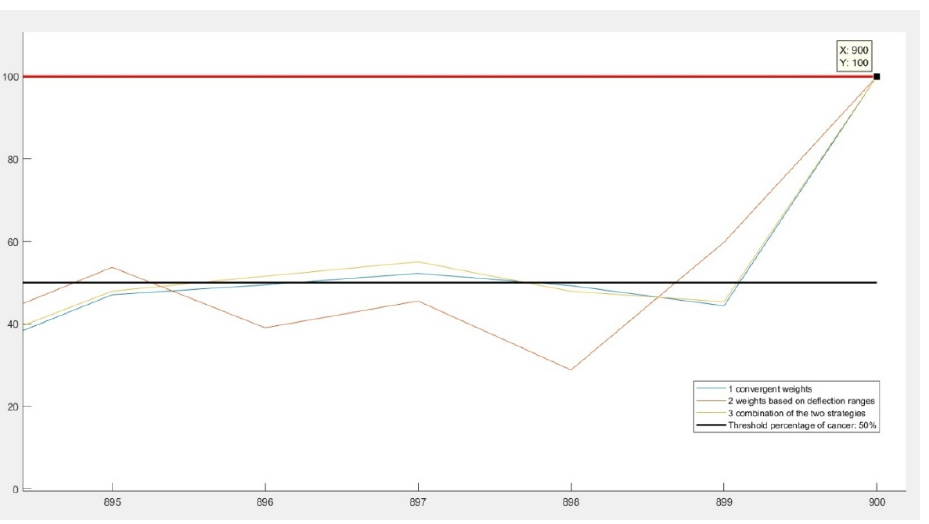
Figure 4. Normalization of the resulting percentages.